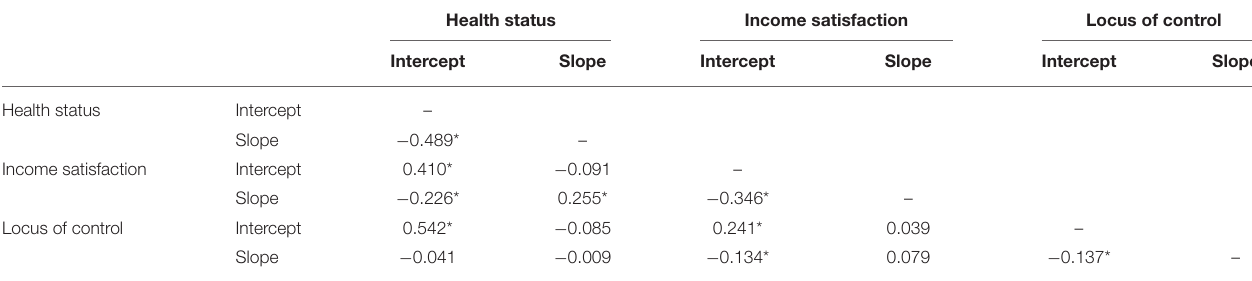
TABLE 7 | Random intercept and slope